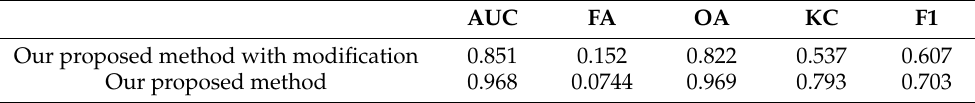
Table 6. The performance comparison for California to show the role of feature classification part.